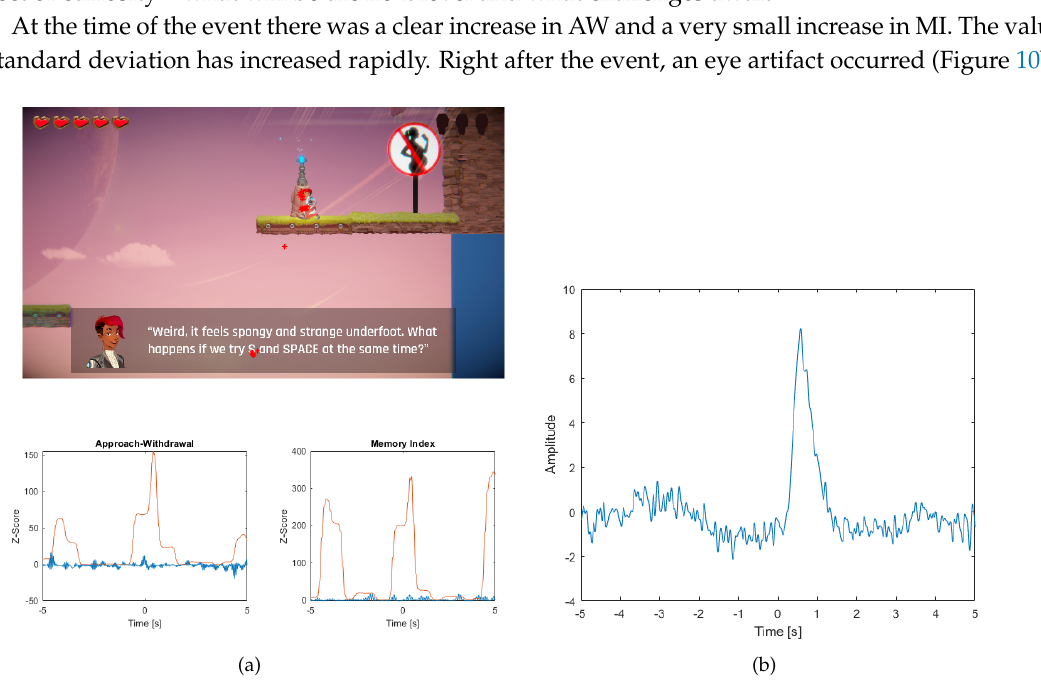
Figure 10. ( a ) The picture shows a screenshot of the game, where the hero is in the middle of the next level. In the picture, the points where the player is looking are marked with red stars. Below are the graphs (blue) of the Approach-Withdrawal and Memory Index and the standard deviation value for both indices (red line) ( b ) A graph showing the occurrence of an ocular artifact for an event related to the hero’s transition to the next